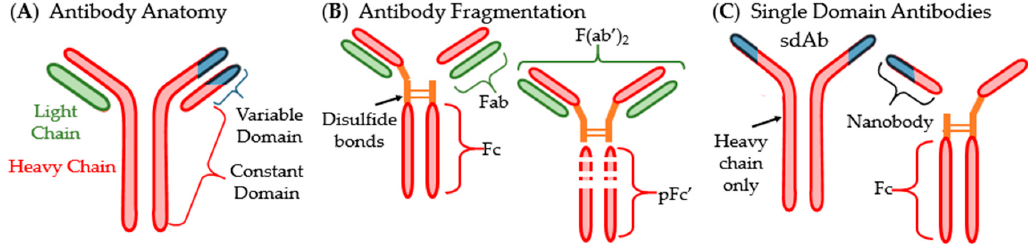
Figure 2. Structure of antibody and common fragmentation types: ( A ) generic anatomy of an antibody; ( B ) visualization of fragmented antibodies; ( C ) single domain antibodies (sdAbs) and their fragmentation. Antigenbindingfragments(FabsorFvs)canoftenbeusedinplaceofwholeantibodies.